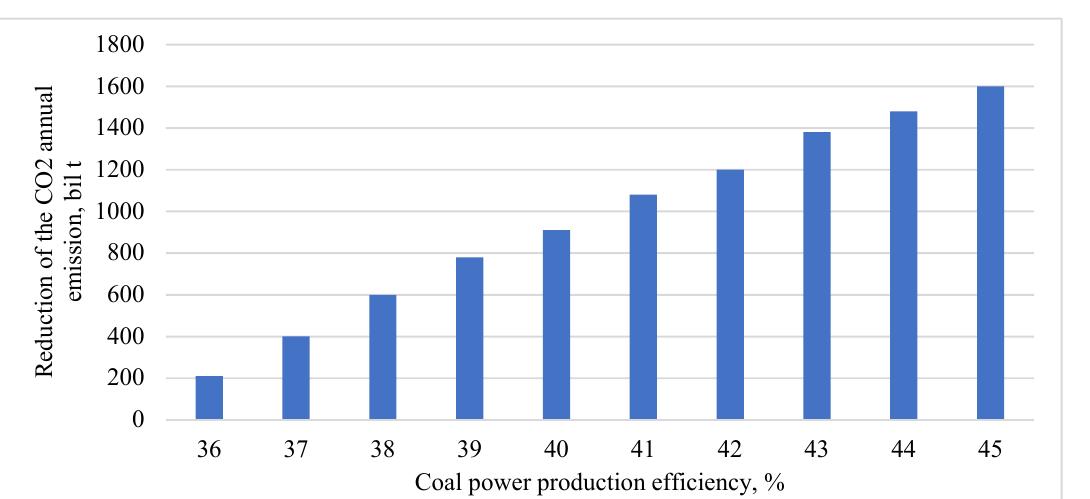
Figure 3. Coal-based power production in the countries with advanced power industries: 1—Japan, 2—USA, 3—Germany, 4—China, 5—Russia.